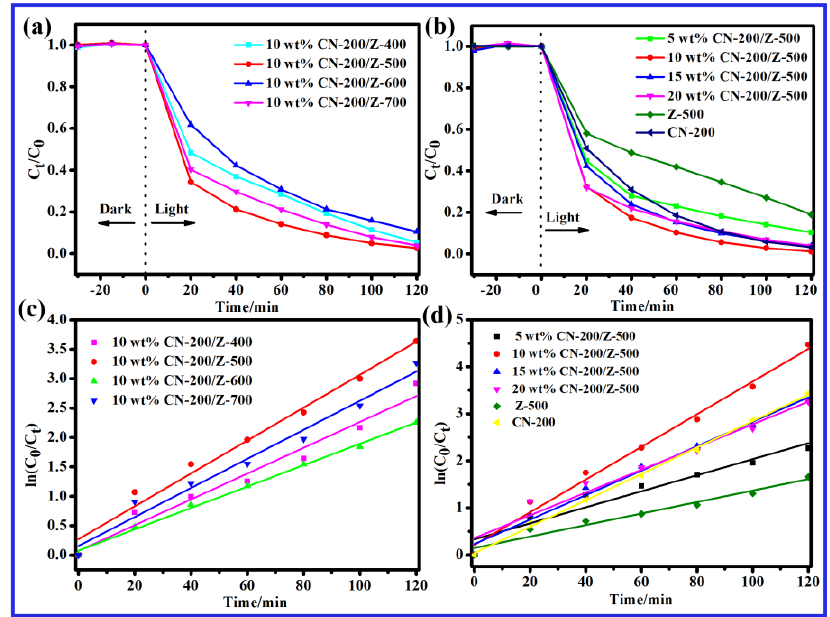
Figure 6. ( a , b ) Photocatalytic activity of MB degradation photocatalyst under visible light irradiation; ( c , d ) first-order kinetic curve of MB degradation photocatalyst under visible light irradiation.